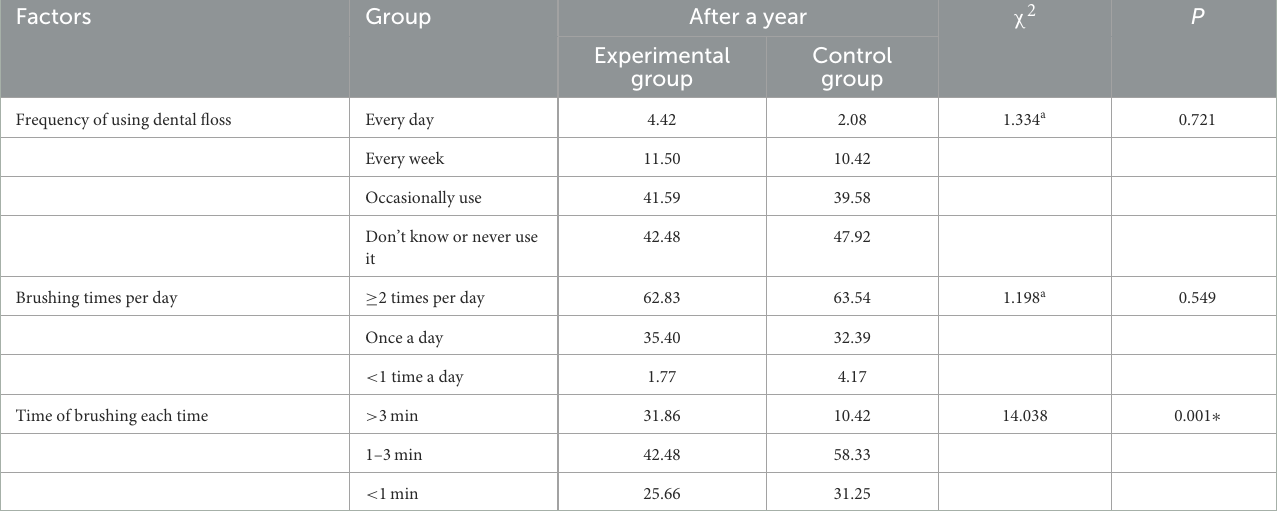
TABLE 4 Oral hygiene behavior of the two groups after a year (%). Factors